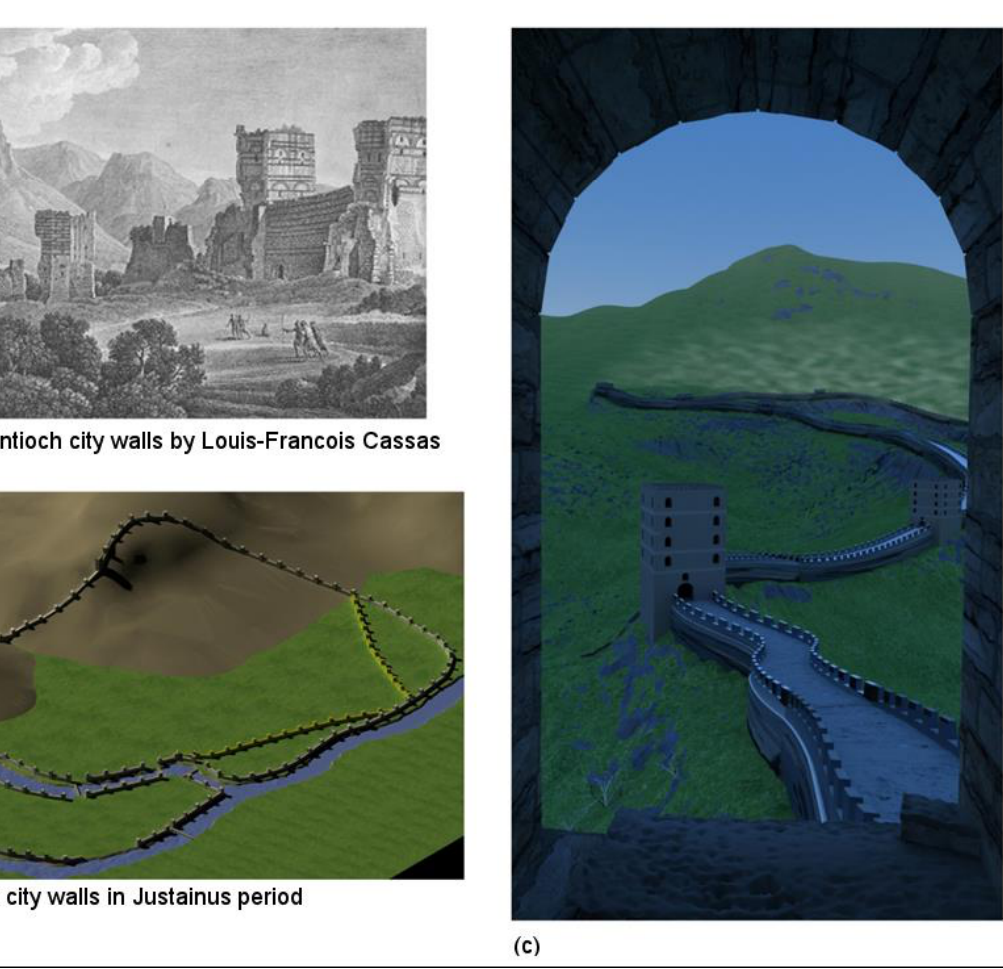
Figure 10. An 18th-century gravure by Louis-Francois Cassas [2 5] depicting Ancient Antioch’s city walls (a), and the model produced from this gravure (b,c). walls ( a ), and the model produced from this gravure ( b , c